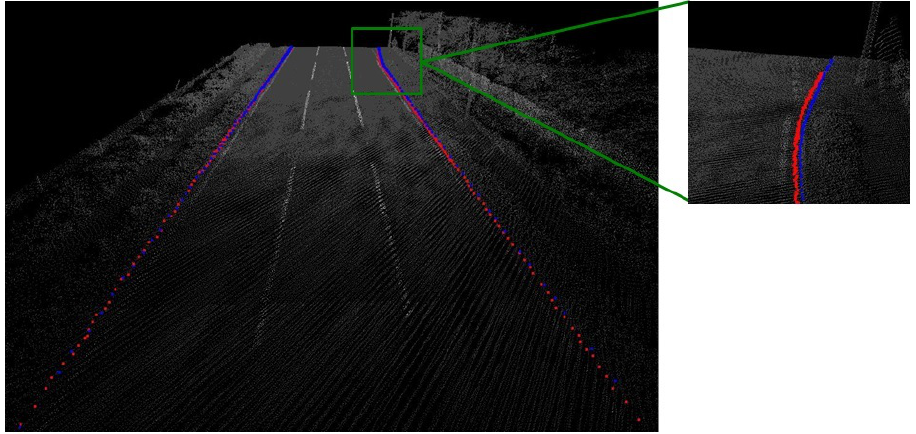
Figure 10. The extracted 3D edges are represented in red, and the manually-digitised 3D edges are represented in blue in the 50-m road section. The inset picture of right edge shows some of the points in